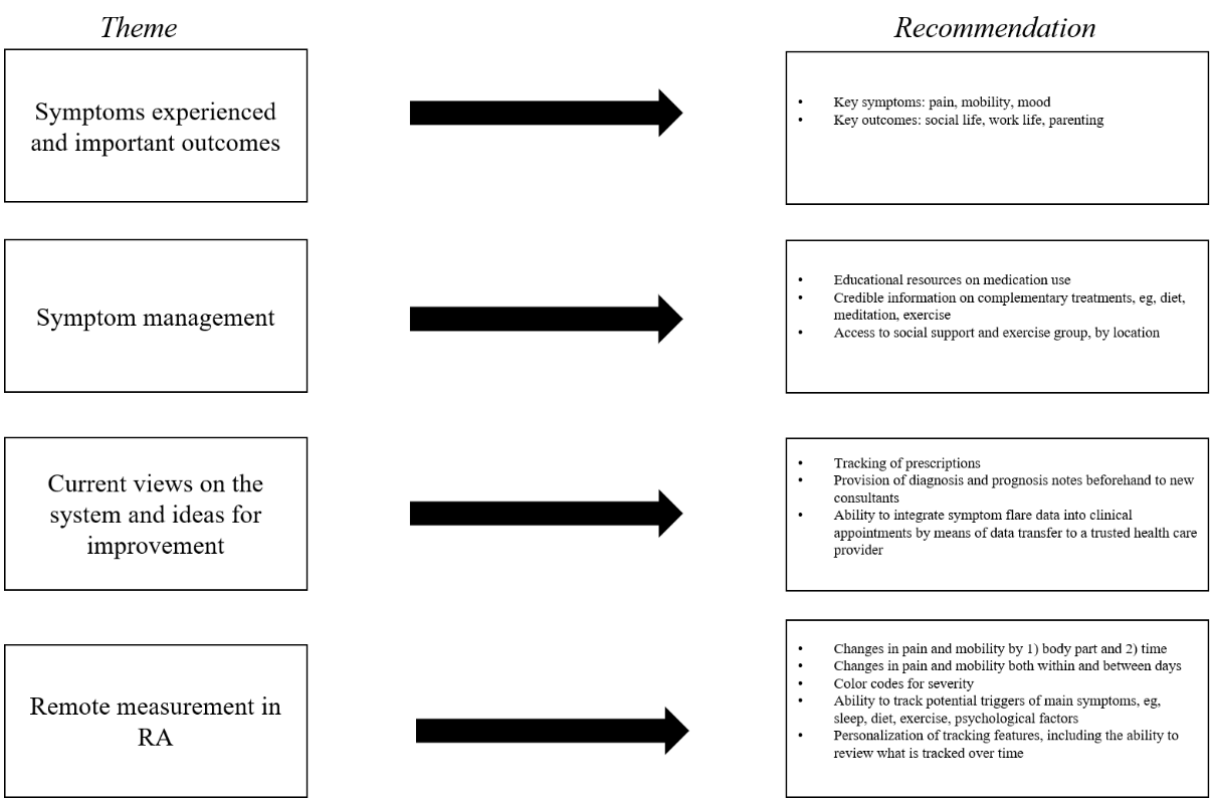
Figure 2. Key recommendations for consideration in a remote measurement technology system for rheumatoid arthritis symptom tracking, split by key theme. RA: rheumatoid